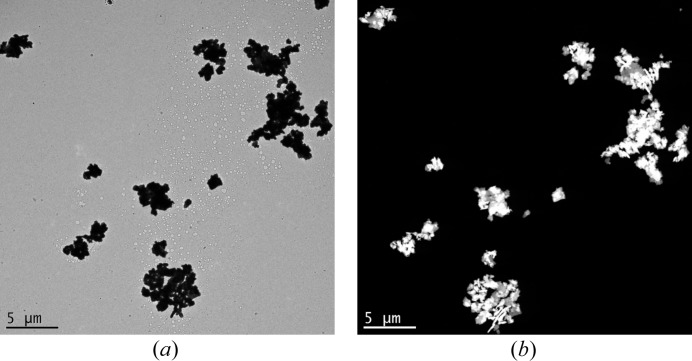
TEM image (a) and HAADF-STEM image (b) of the same area of BaSO4 crystals.